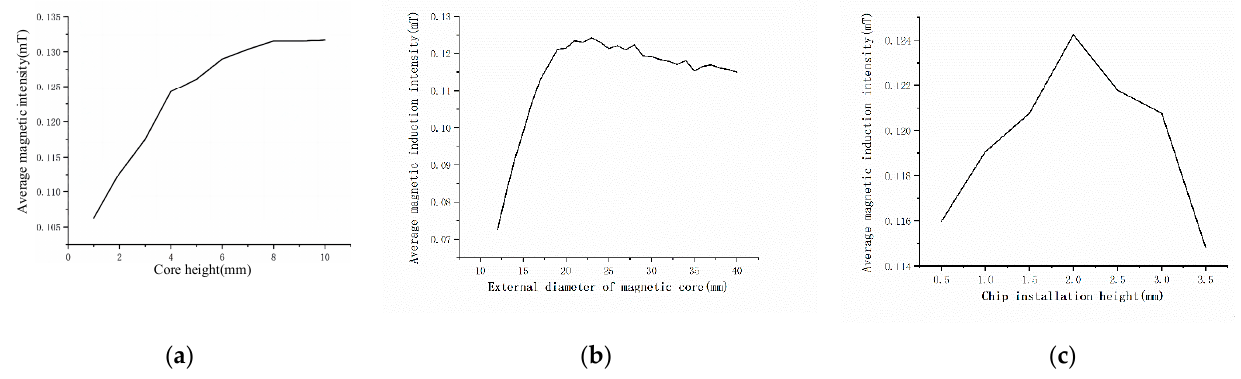
Figure 5. Change in the average magnetic induction intensity with core structure: ( a ) variation in core height; ( b ) variation in outer diameter of magnetic ring; and ( c ) change in the installation height of the fluxgate chip.